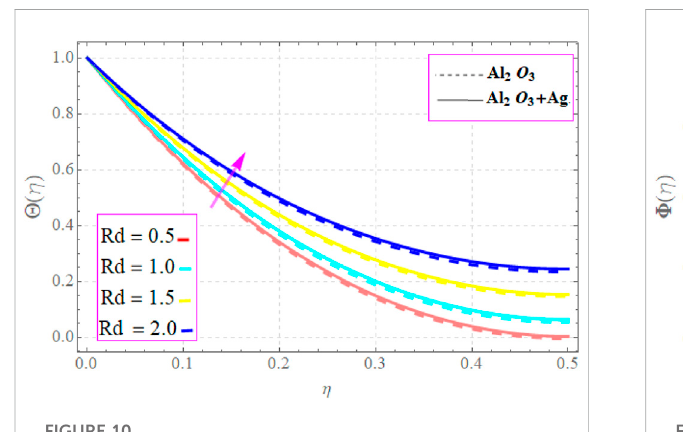
FIGURE 10 In fl uence of Rd on Θ ( η ) .